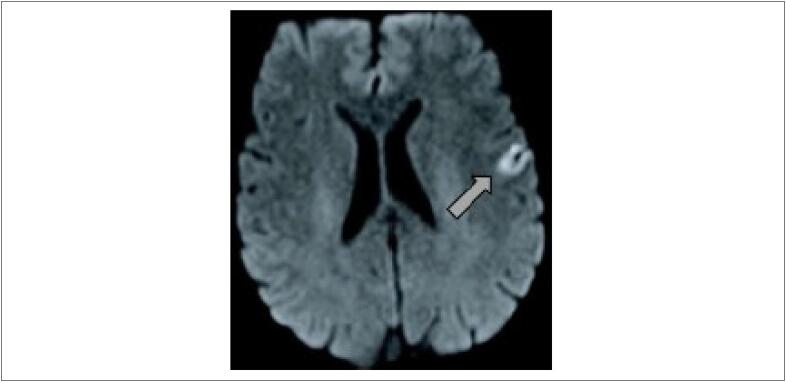
Cerebrovascular accident (CVA) - Magnetic Resonance Imaging of a Patient with CVA – Hyperintense lesion on Flair sequence in the left central gyrus topography, compatible with acute ischemia.